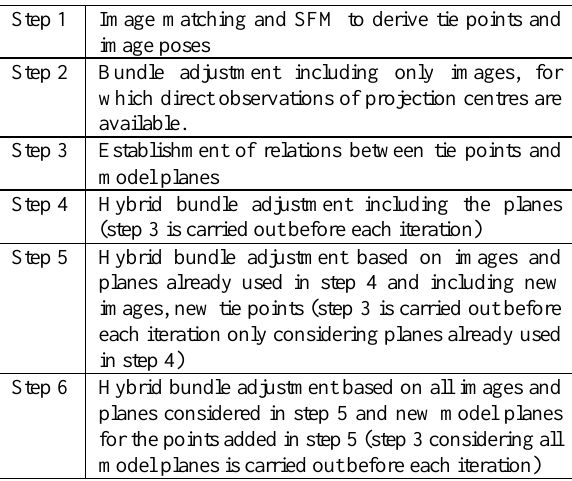
Table 1: Work flow of pose